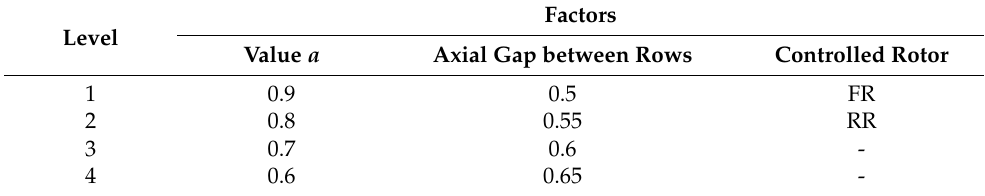
Figure 9. The code results of controlling the blade load. Table 6. Levels of each